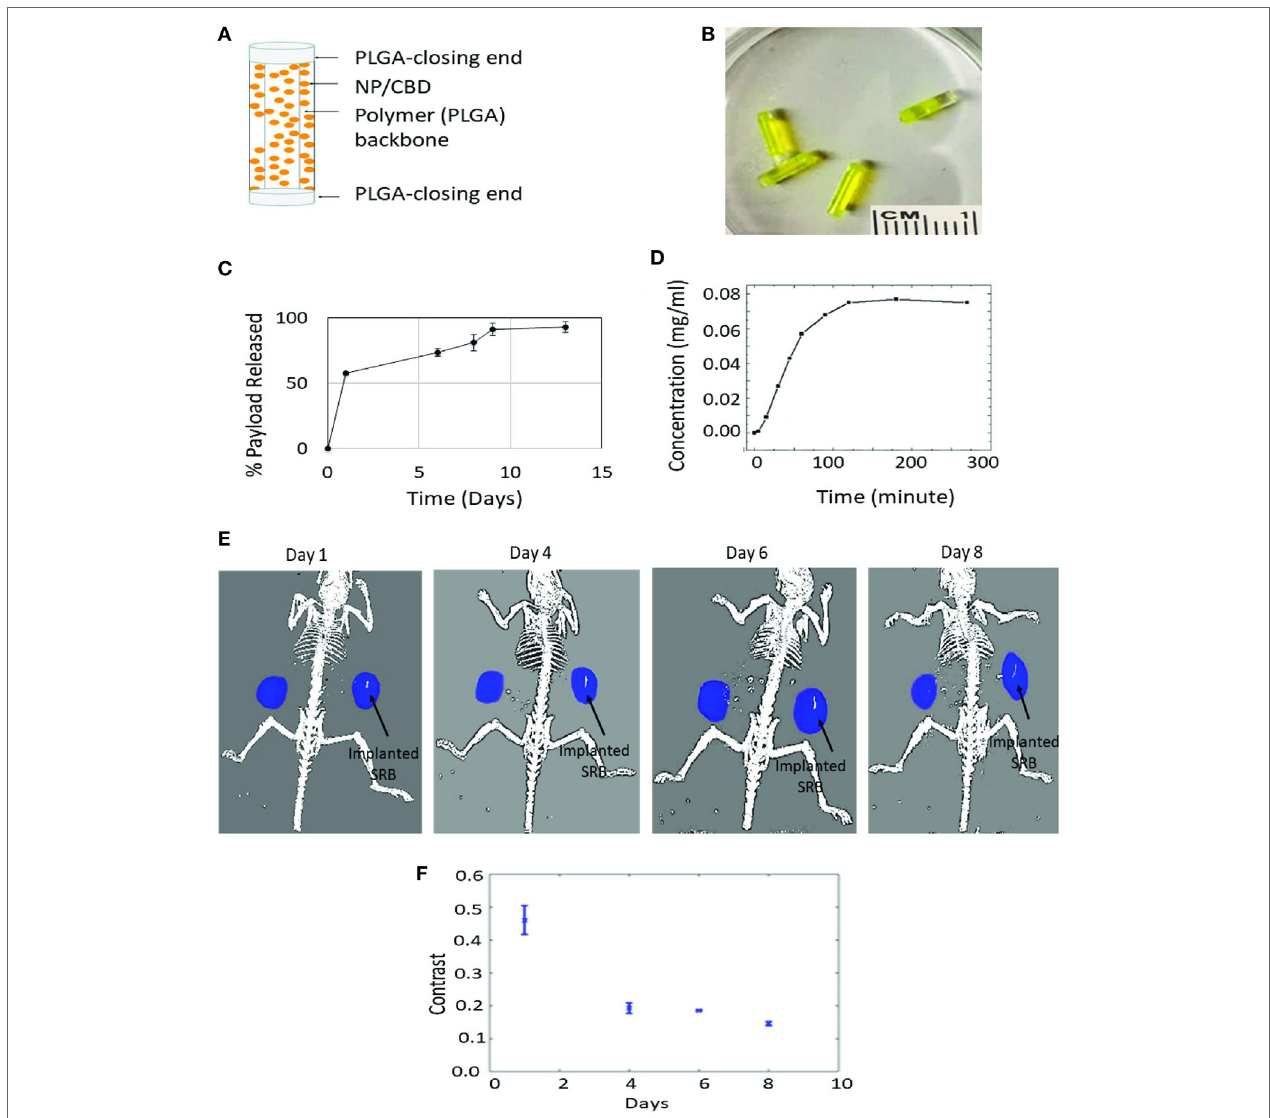
FigUre 3 | Sustained release of cannabinoid (CBD). (a) One design of multifunctional smart biomaterial (SRB) made of Food and Drug Administration-approved biocompatible biodegradable polymer loaded with a payload of CBDs/nanoparticles (NPs); (B) actual SRBs with payload; (c,D) in vitro release of CBD payload from SRB, demonstrating the ability for (c) sustained release over many days, and (D) quick release. The release kinetics (i.e., how slow or fast) can be optimized to treatment schedules, by varying the degree of cross-linking in the polymer or the polymer weighting. (e) Computed tomography image of mouse imaged over time with small animal radiation research platform showing degradation of SRB as payload is released over time in the tumor on the right side of image. (F) Average pixel intensity from maximum amplitude image for all image slices. The data are obtained from evaluating the same region of interest in the processed maximum intensity